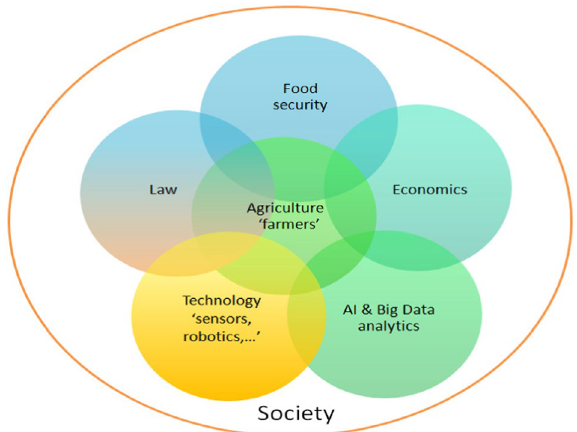
Fig. 1 The interlocked sectors involved in